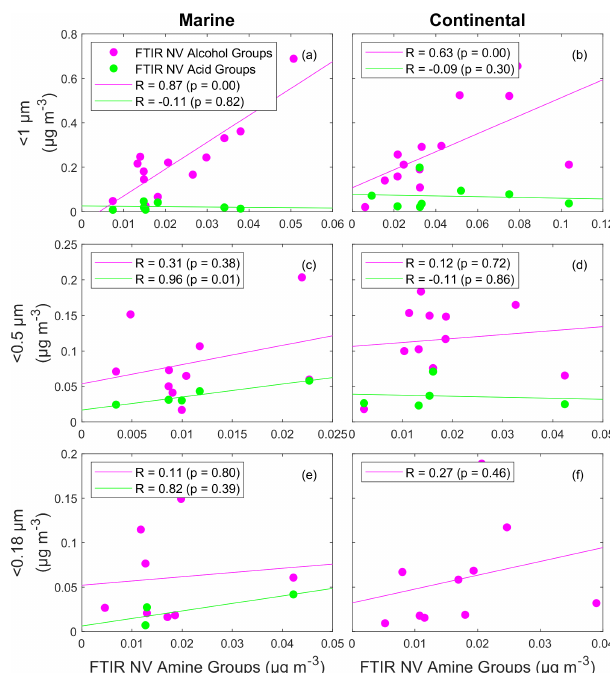
Figure 7. Scatterplot of FTIR primary (FTIR NV alcohol group: pink) and secondary (FTIR NV carboxylic acid group: green) trac- ers versus FTIR NV amine groups for marine filters (a, c, e) and continental filters (b, d, f) with functional group concentrations twice the standard deviation. The panels show the three filter size cutoffs: 1µm (a, b) , 0.5µm (c, d) , and 0.18µm (e, f) . The solid lines are the lines of best fit obtained using an ordinary least squares re- gression. A two-tailed t test is used to estimate p